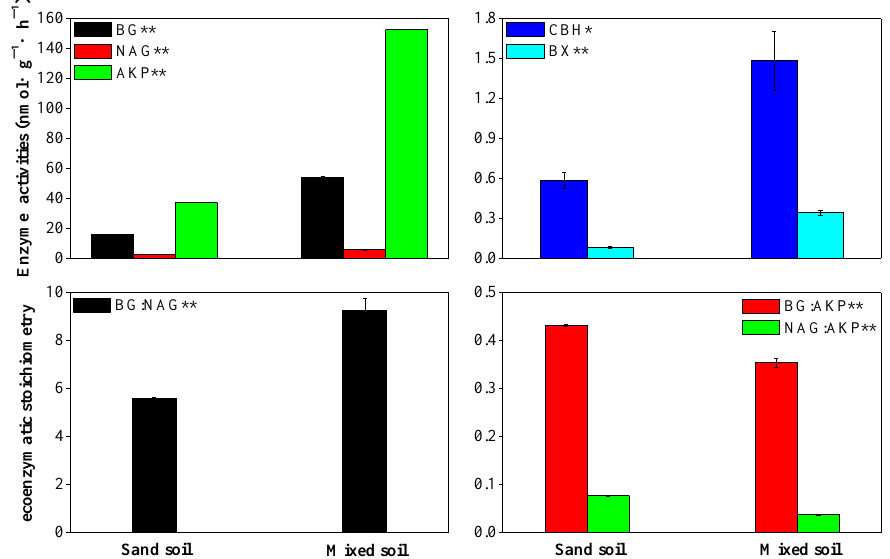
Figure 2. Soil extracellular enzyme activity and ecoenzymatic stoichiometry in sand vs. a mix of sand and feldspathic sandstone. * and ** indicate statistical significance at the 0.05 and 0.01 probability levels, respectively. Error bars are the standard errors ( n = 3). Table 3. The vector characteristics of enzyme activity in sand vs. a mix of sand and feldspathic sandstone. Metric Sand Soil Mixed Soil F (1, 5) p BG / (BG + AKP) 0.302 ± 0.001 0.262 ± 0.005 67.09 < 0.01 ** BG / (BG + NAG) 0.85 ± 0.01 0.90 ± 0.01 116.41 < 0.01 ** Vector length 0.90 ± 0.01 0.94 ± 0.01 39.91 < 0.01 ** Vector angle 70.41 ± 0.06 73.82 ± 0.20 278.87 < 0.01 ** Values are expressed as mean ± SE, n = 3. All samples included the values for β -1,4-glucosidase (BG), β -N-acetylglucosaminidase (NAG), and alkaline phosphatase (AKP). Vector angles in degrees, all other vector characteristics unitless. Calculations for vector length and vector angle described in the main text. ** means that the differences between the two lands for a metric is significant at the 0.01 level.